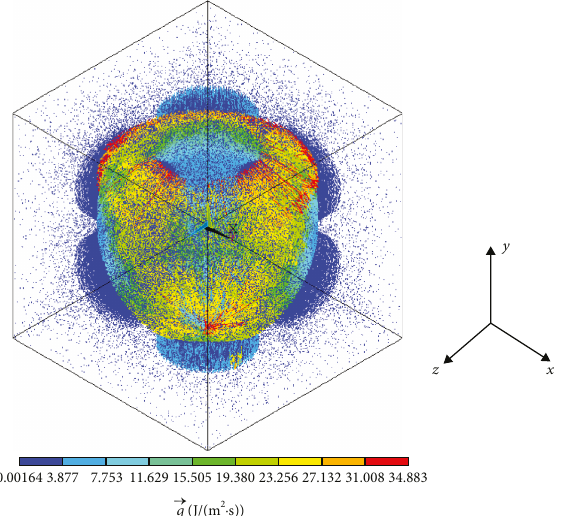
Figure 25: Microsphere carbonization